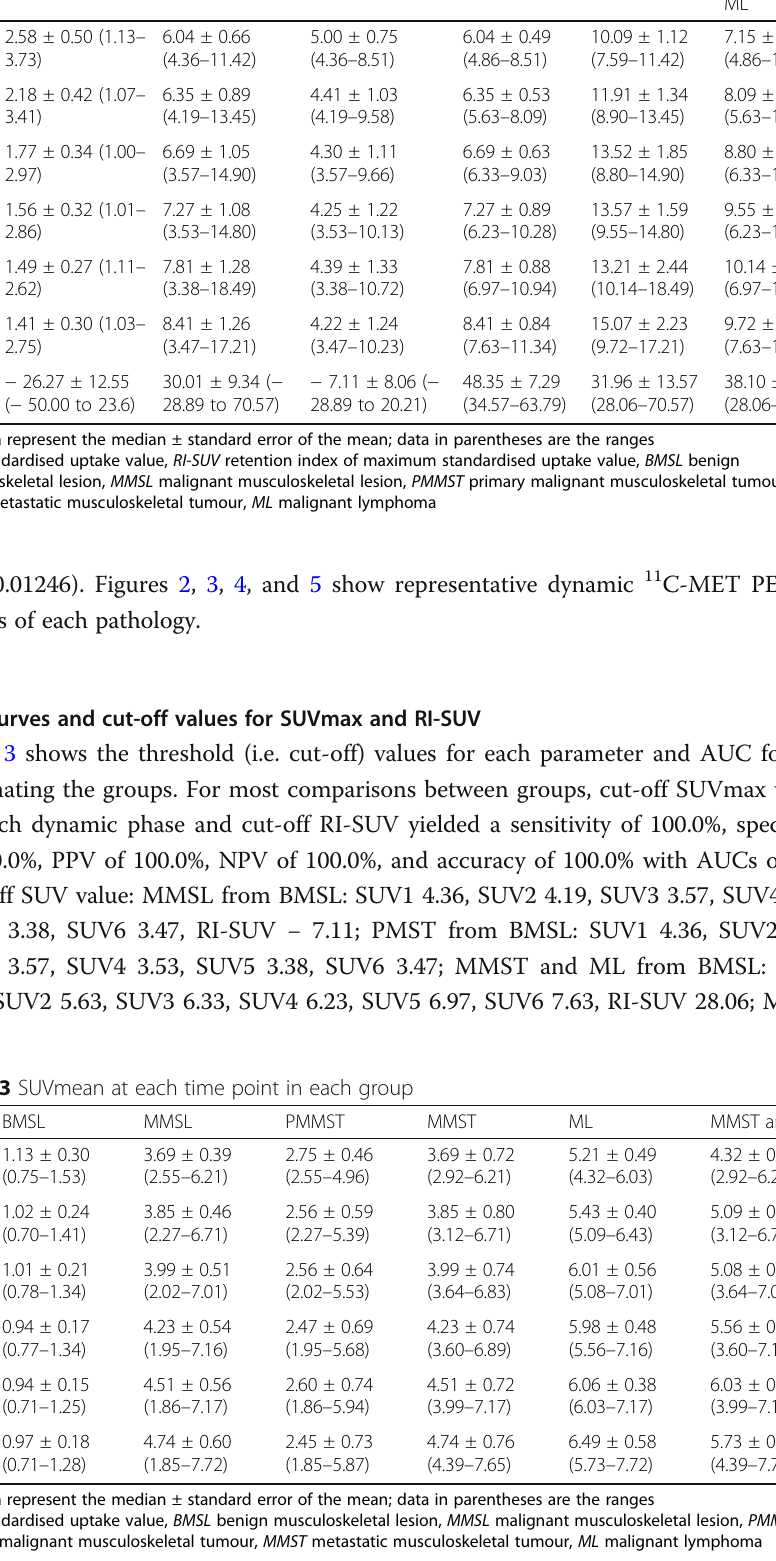
Table 2 SUVmax and RI-SUV at each time point in each group Group BMSL